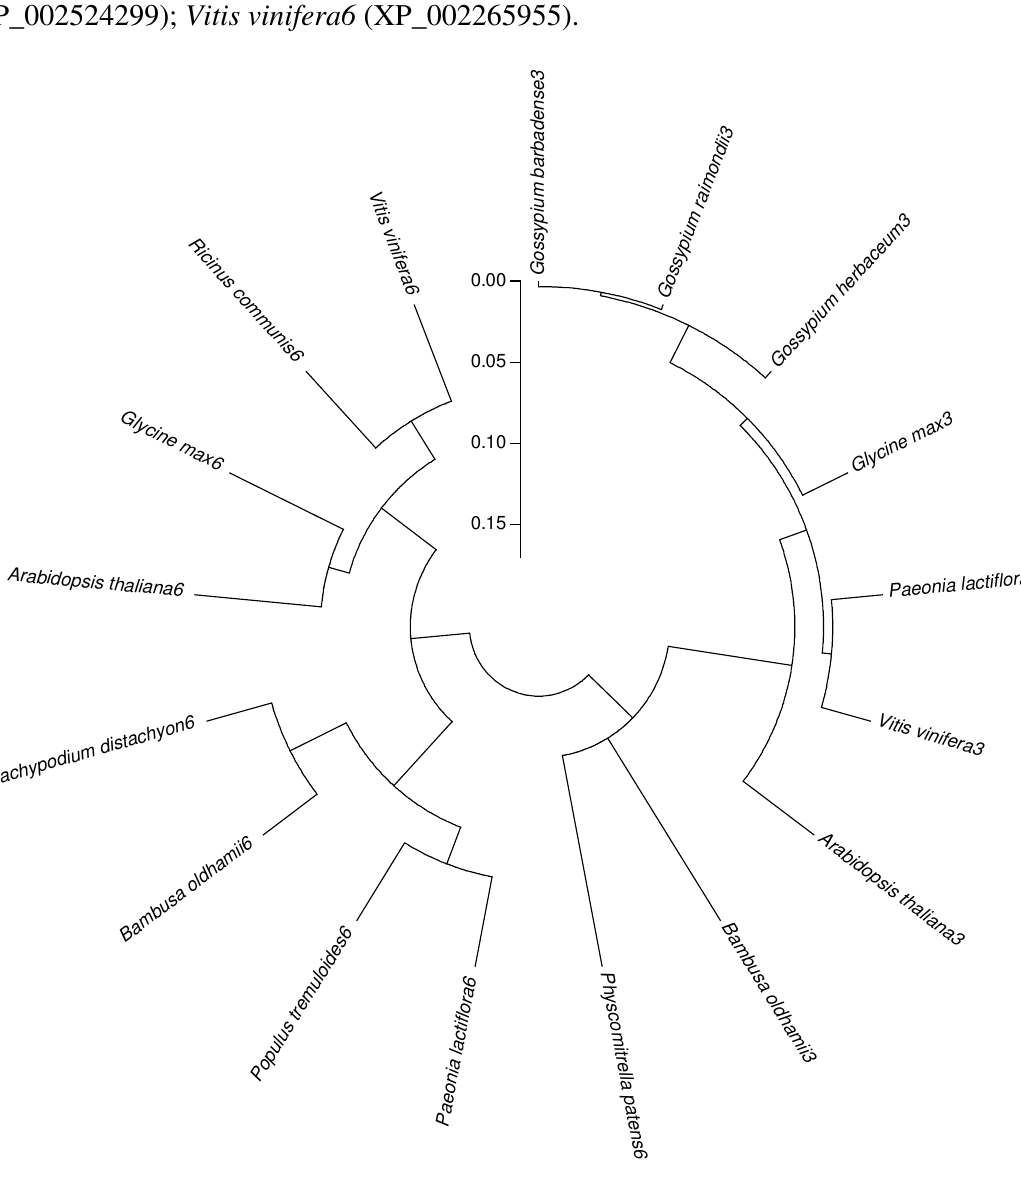
Figure 4. Phylogenetic tree of PlCesA3 , PlCesA6 and CesA from some other plants. The amino acid sequences were obtained from GenBank: Arabidopsis thaliana3 (NP_196136); Bambusa